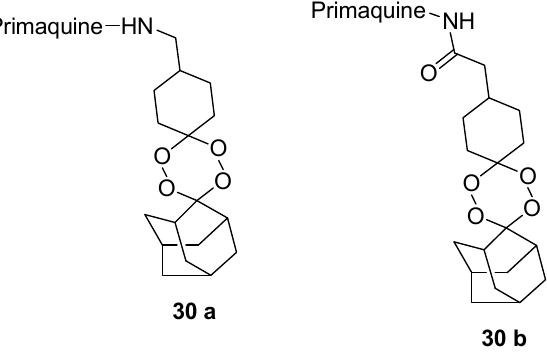
Figure 5. Quinoline-trioxolanes hybrid compounds.